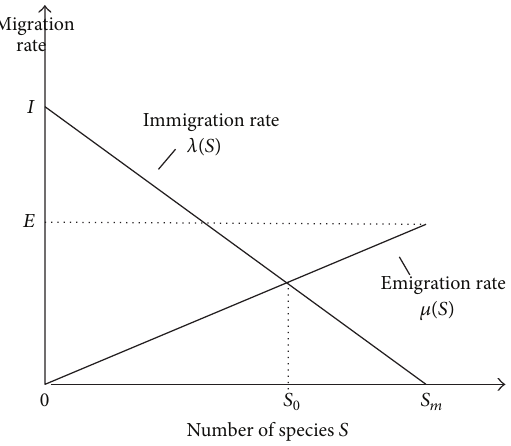
Figure 2: Species migration